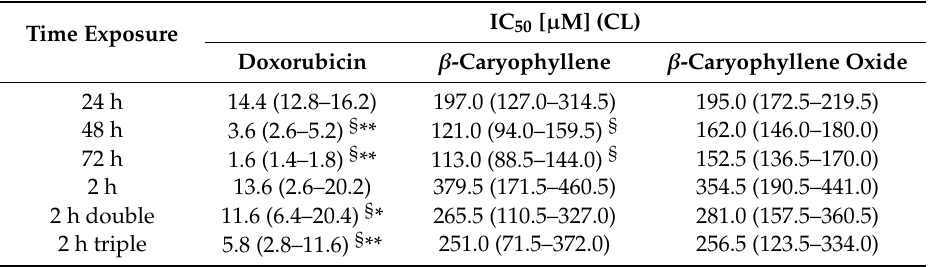
Table 1. IC 50 values of doxorubicin and caryophyllane sesquiterpenes under both long-term and metronomic schedules. In the last protocol, the cells were subjected to a short and / or repeated exposure of 2 h to the test substances followed by a recovery time of 72 h. Data represent the mean ± SE (standard error) of at least two experiments in which each treatment was tested in triplicate ( n =